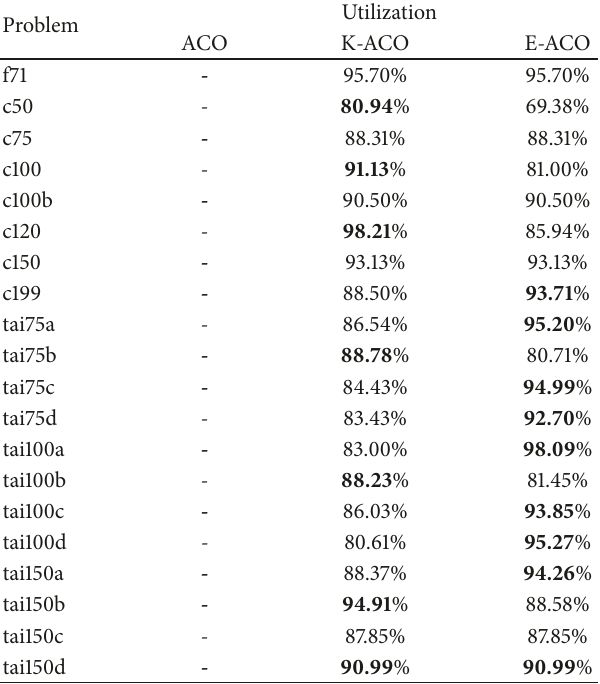
Table 4: Comparison of vehicles’ utilization